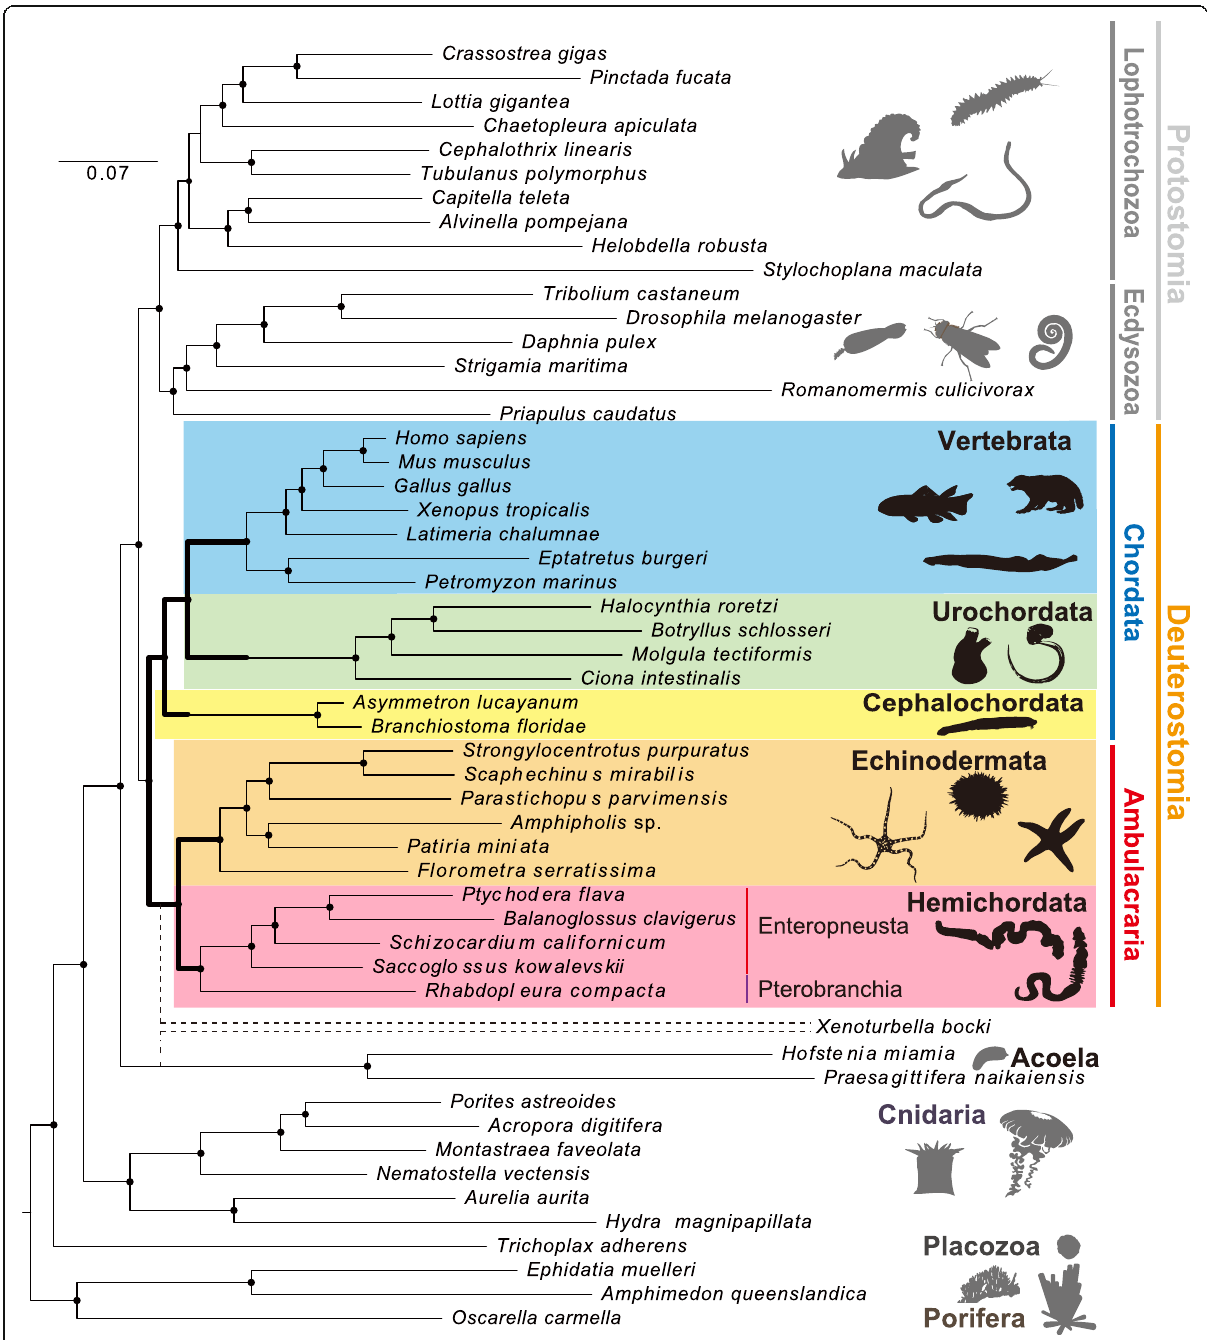
Fig. 2 Molecular phylogeny of deuterostome taxa within the metazoan tree. Echinoderms are shown in orange, hemichordates in magenta, cephalochordates in yellow, urochordates in green, and vertebrates in blue. The maximum-likelihood tree was obtained with a supermatrix of 506,428 amino acid residues gathered from 1564 orthologous genes in 56 species (65.1% occupancy), using a Γ + LG model partitioned for each gene. Plain circles at nodes denote maximum bootstrap support. This tree clearly indicates that Deuterostomia comprises two discrete